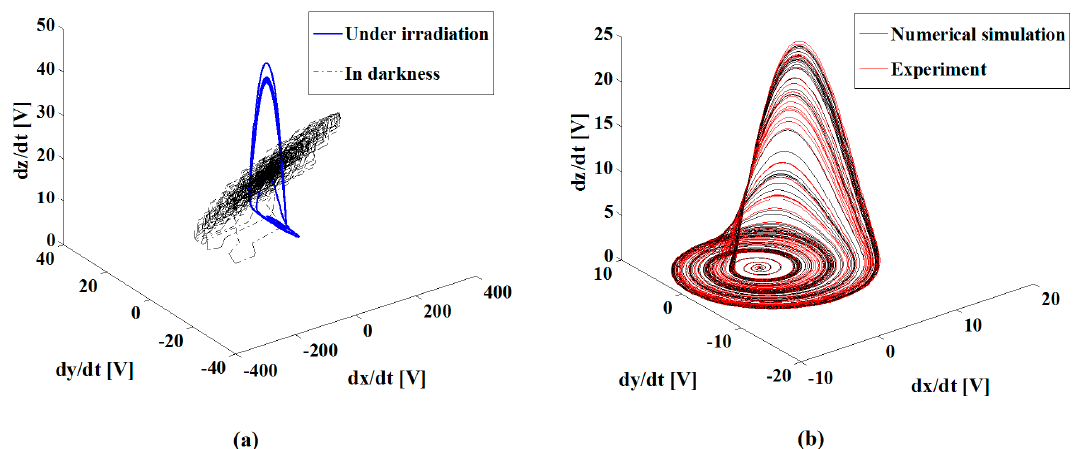
Figure 7. Experimental and numerical data obtained by chaotic modulation in conductivity measurements. ( a ) Comparison of one experimental measurement on the edge stability of the system, and another with unstable behavior; the first one under irradiation and the second one in darkness; ( b ) Steady-state Rössler attractors obtained in the studied sample.